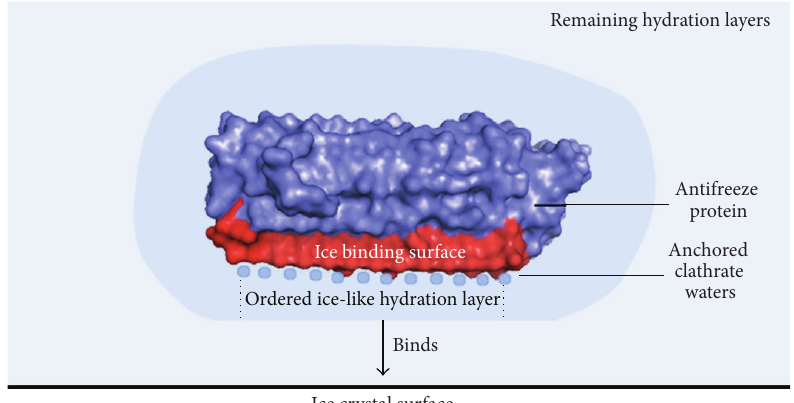
Figure 9: Schematic diagram of ice binding using an ice-like hydration layer ( Mp AFP retrieved from RCSB Protein Data Bank). Anchored clathrate waters in the troughs of the ice binding surface orders the hydration layer to become ice-like. This hydration layer become an ice template allowing binding to ice crystal surfaces. The ice binding surface of the antifreeze protein is highlighted in red using